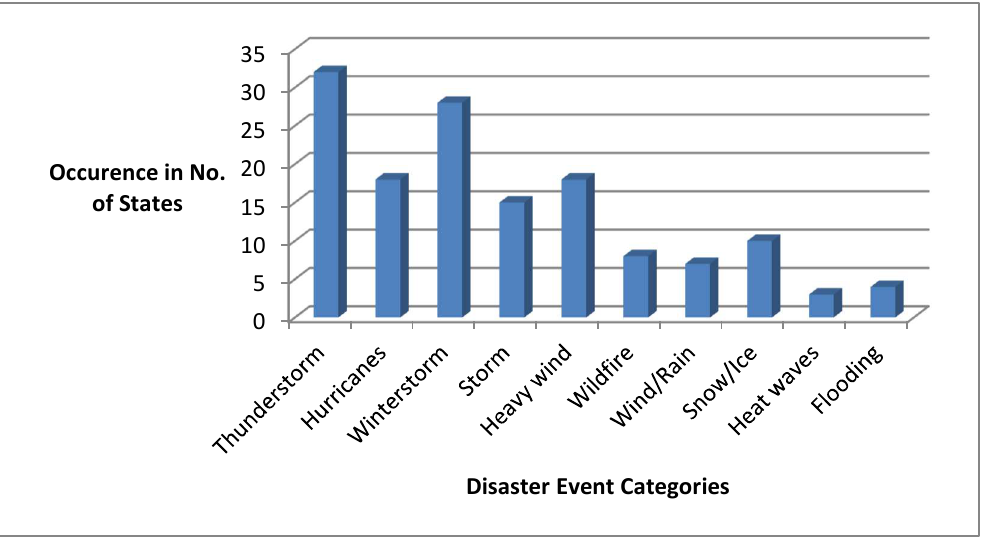
Figure 3. Distribution of frequency of natural disaster events in multiple states of the U.S.